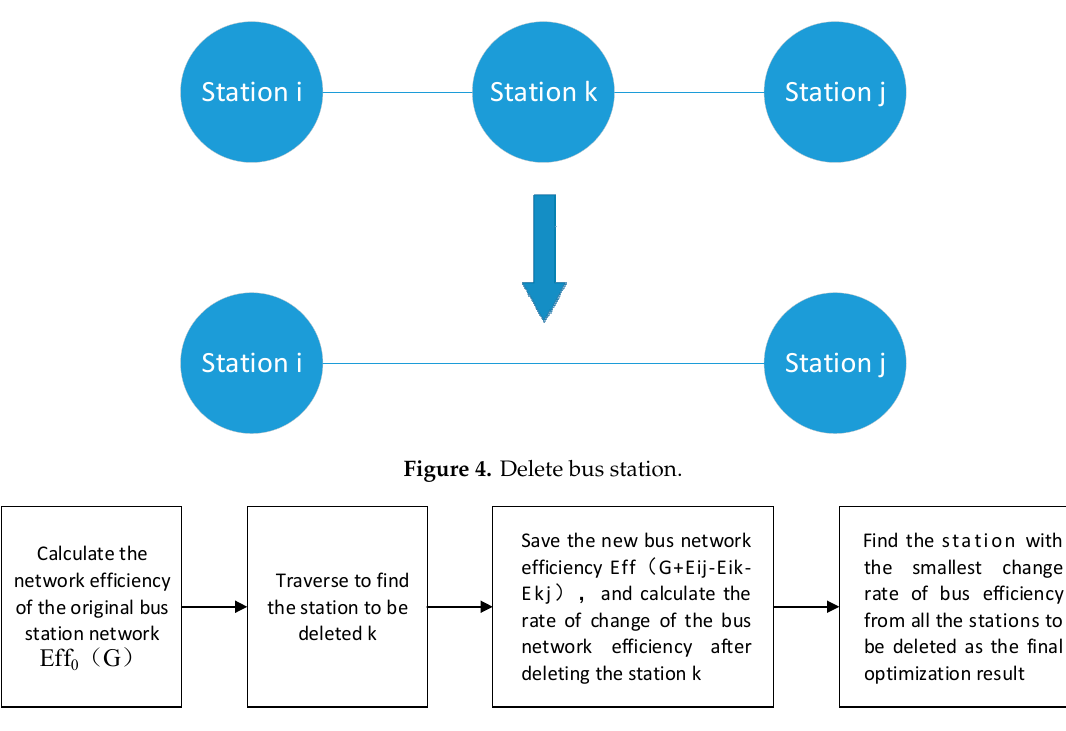
Figure 5. Delete bus stops flow chart.